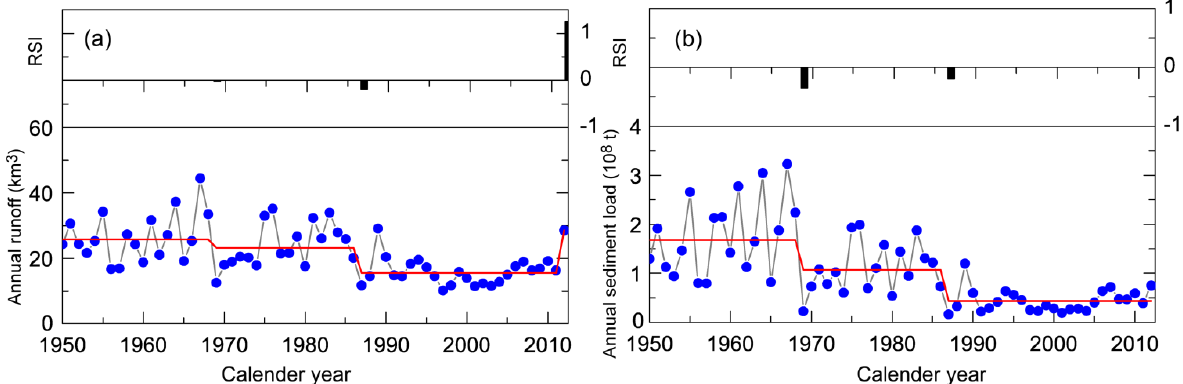
Figure 4. Regime shift detection in the annual runoff and sediment loads at the Toudaoguai station. ( a ) Regime shift by STARS for annual runoff and ( b ) annual sediment at Toudaoguai